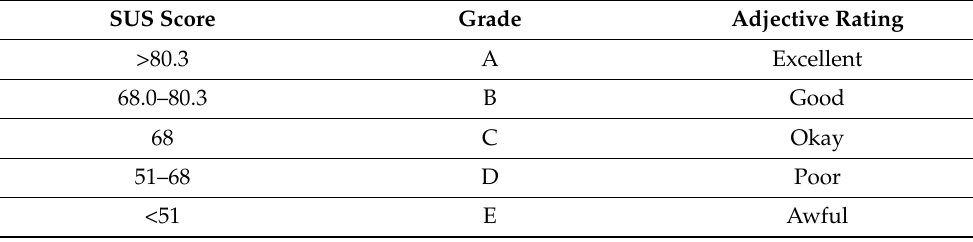
Table 8. General guideline of SUS Score interpretation